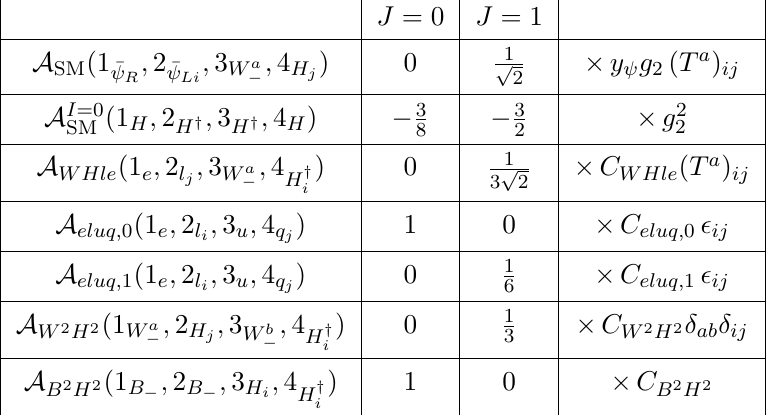
Table 1 . Values of the coefficients a J in the s -channel for the different SM amplitudes (up to J = 1 ) and SM EFT amplitudes at O ( E 2 / Λ 2 ) discussed in the text. For A I =0 coefficient a J | reg (see main